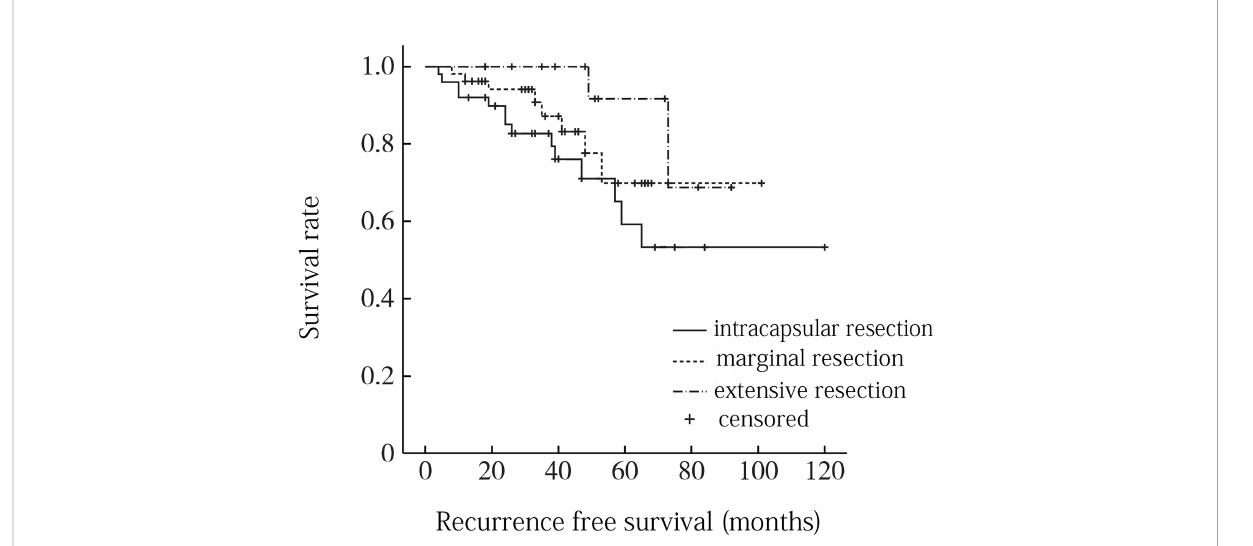
FIGURE 4 Recurrence free survival curve for different surgical resection ranges of sacrococcygeal